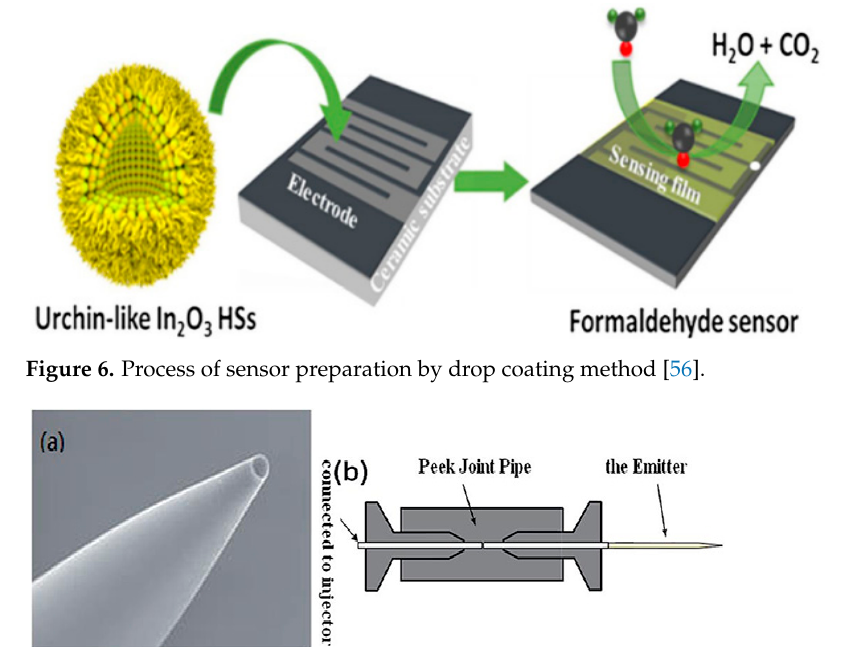
Figure 7. ( a ) PicoTipTM emit image. ( b ) Schematic of the emitter in combination with injector [61].